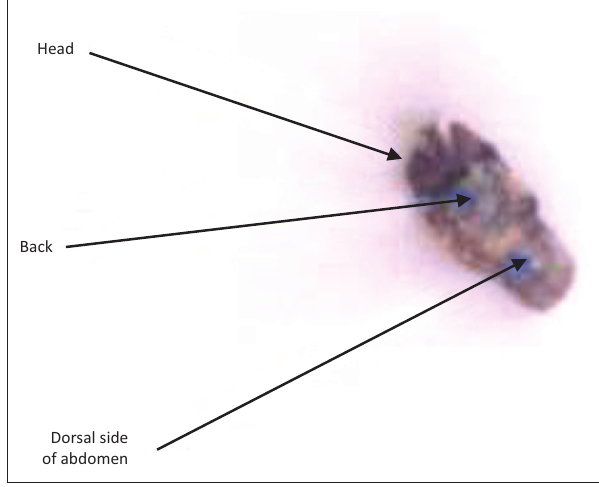
FIGURE 4: Half-developed flies from the pupae that failed to hatch naturally.